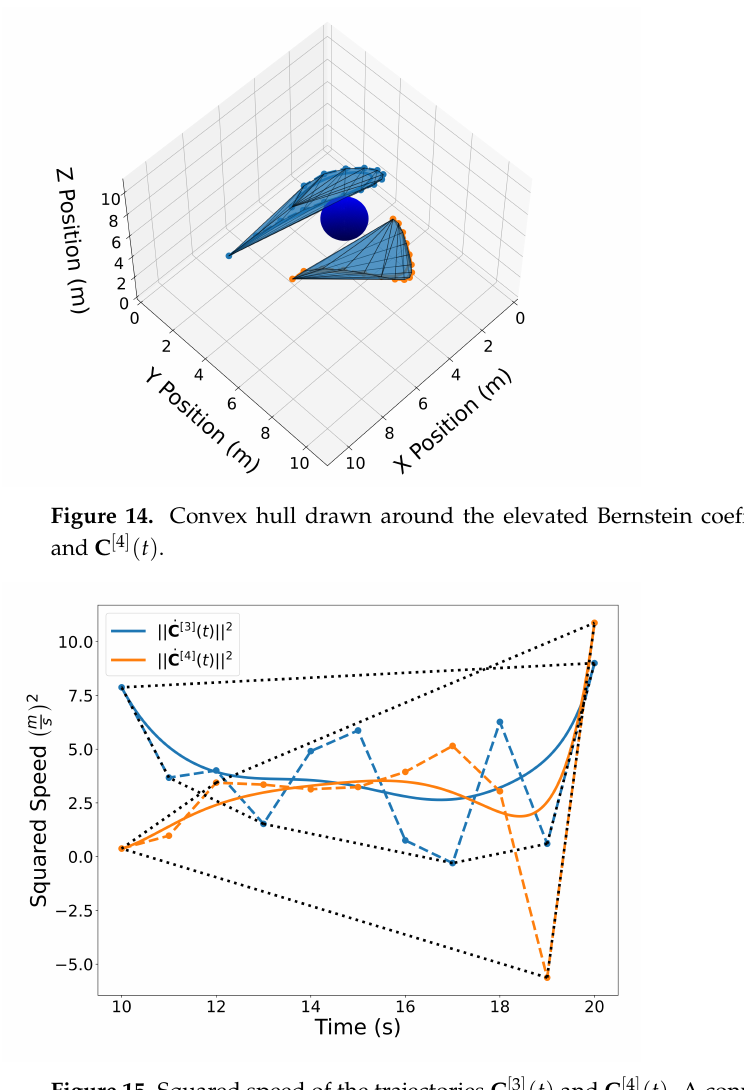
Figure 15. Squared speed of the trajectories C [ 3 ] ( t ) and C [ 4 ] ( t ) . A convex hull is drawn around the Bernstein coefficients. Note that even though the coefficients may be negative, the actual curve is